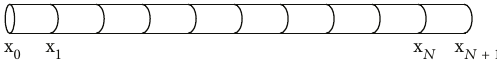
Figure 3: Wire divided into